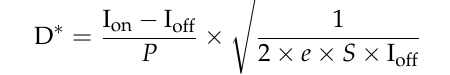
Figure3showstheevolutionofphotoelectricperformanceofthehybridZnOQD/(PEA) 2 PbI 4 nanosheet photodetectors as a function of ZnO QD concentrations, and the configuration of the device is depicted in Figure 3a. In order to deeply study the role of ZnO QD, the